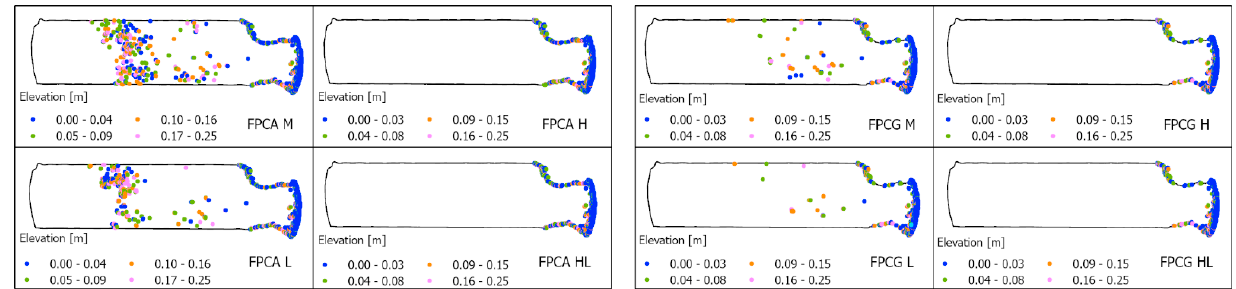
Figure 15. Distribution of points with height above zero for FPCA clouds ( left ) and FPCG clouds ( right ).